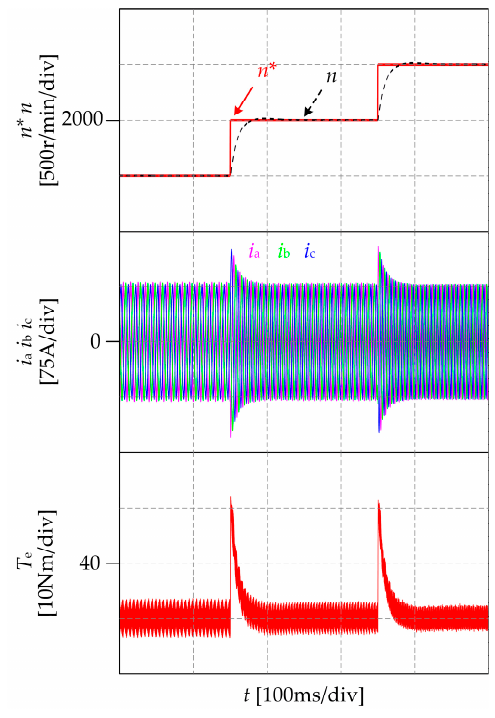
Figure 12. Simulation results of speed transient.